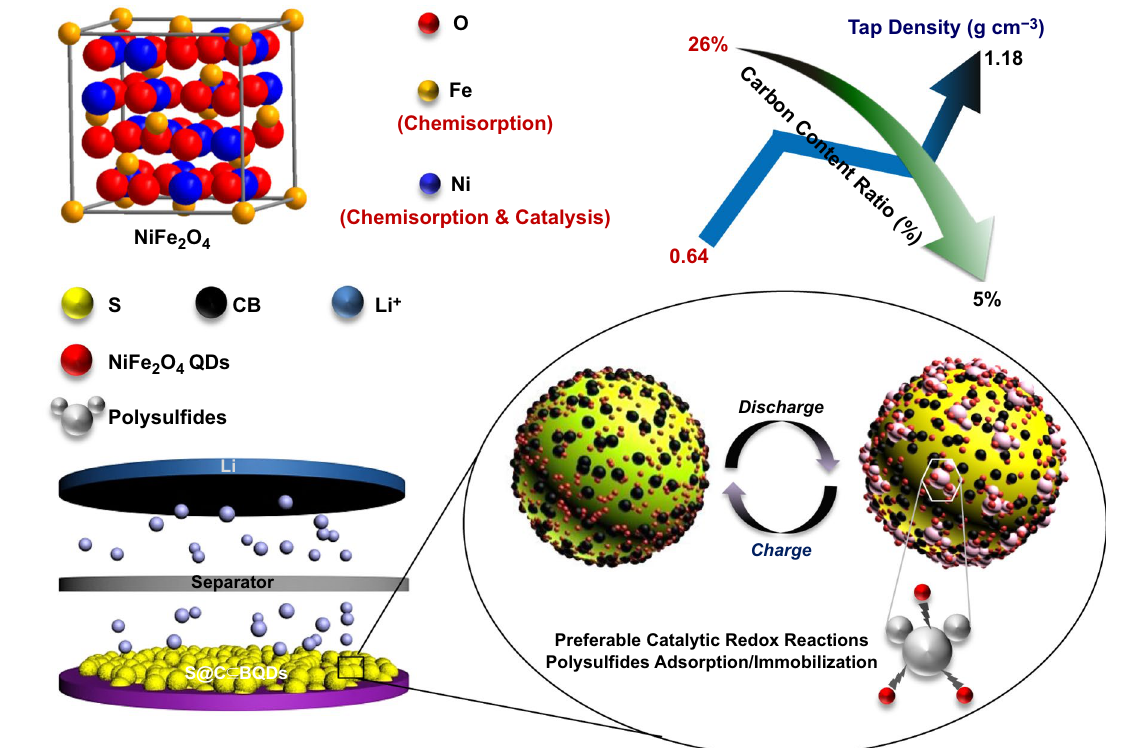
Fig. 1 General schematics showing configured devices of (−)Li//S@CB ⊆ QDs(+) and the working mechanism of NiFe 2 O 4